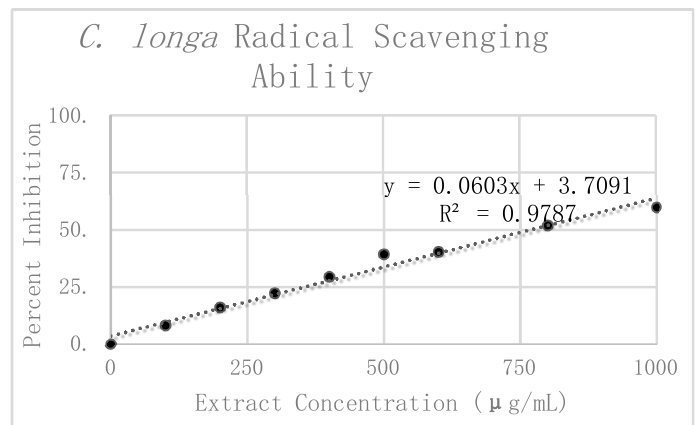
Figure 6. DPPH analysis and radical scavenging ability of C. longa .